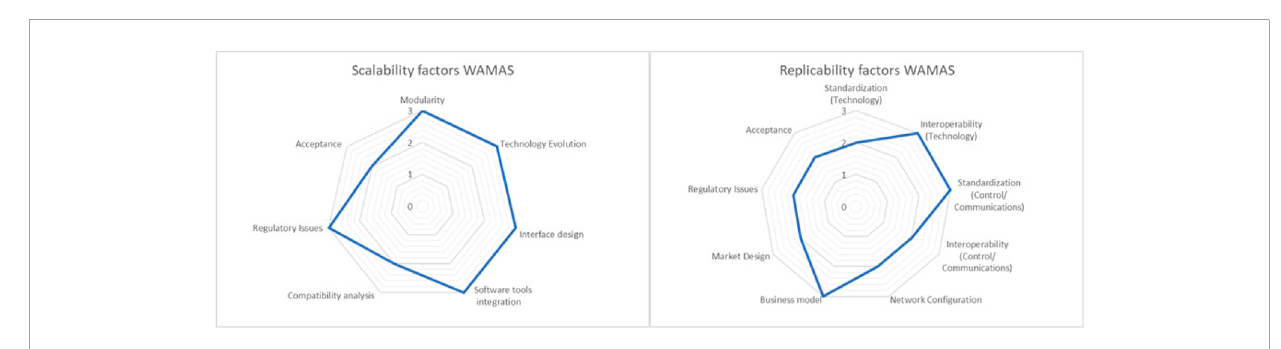
FIGURE 8 Spider graph on WAMAS scalability and replicability